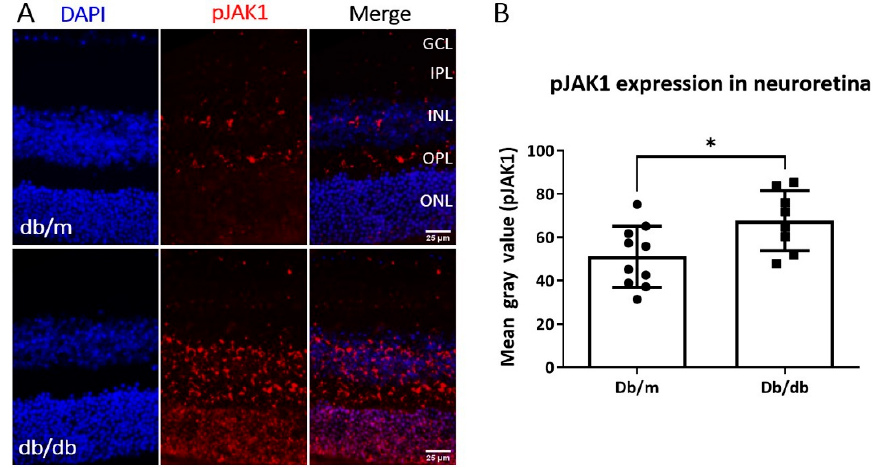
Figure 3. pJAK1 expression in 3-month old db/db mouse retinas. ( A ) Representative images of pJAK1(red) immunostaining, n ≥ 8 animals per group. GCL—ganglion cell layer; IPL—inner plexiform layer; INL—inner nuclear layer; OPL—outer plexiform layer; ONL—outer nuclear layer. ( B ) Quantification of pJAK1 expression in the neuroretina of db/db mice compared to heterozygous non-diabetic controls. Mean ± SD, * p < 0.05, by unpaired t -test.